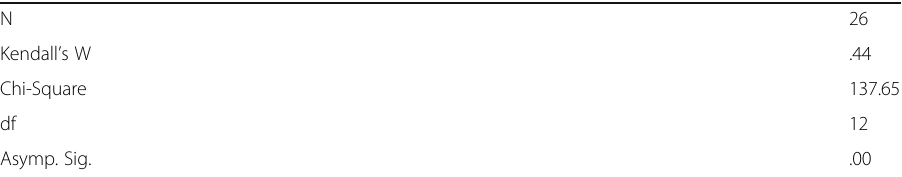
N 26 Kendall ’ s W .44 Chi-Square 137.65 df 12 Asymp. Sig.